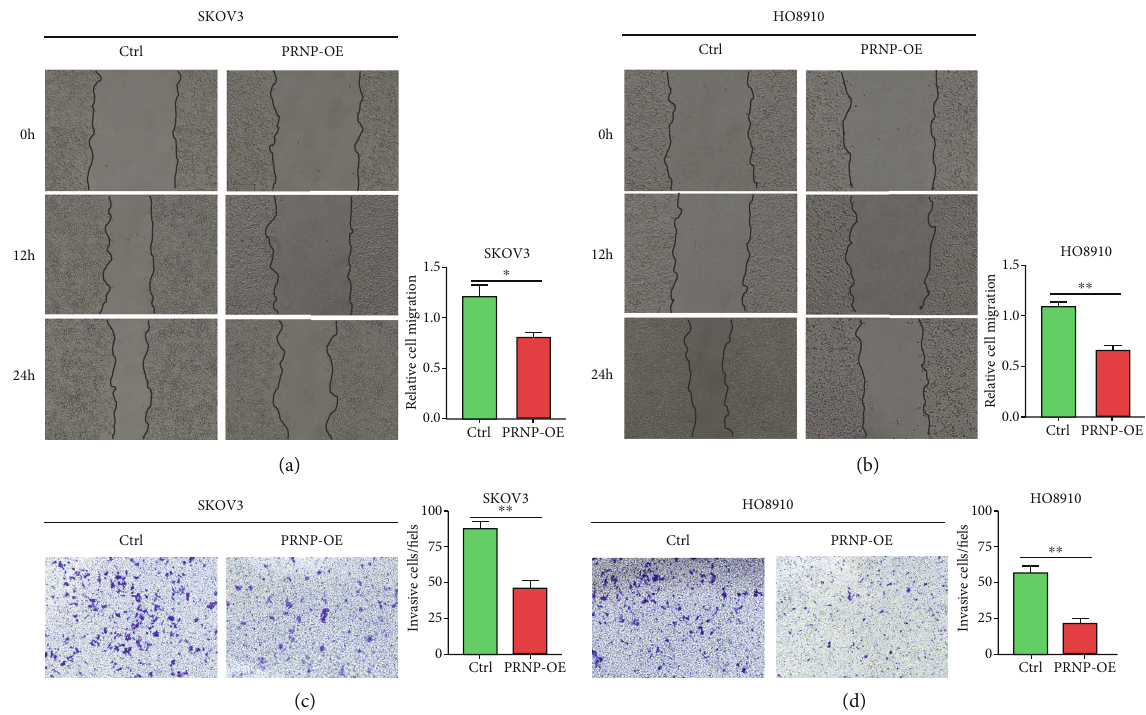
Figure 5: Overexpressed PRNP inhibited the migration and invasion of OC cell lines. (a and b) Scratch wound-healing assay in two OC cell lines with PRNP overexpression. (c and d) Transwell assay in two OC cell lines with PRNP overexpression. OE: overexpression; ∗ p < 0 : 05 , ∗∗ p < 0 : 01